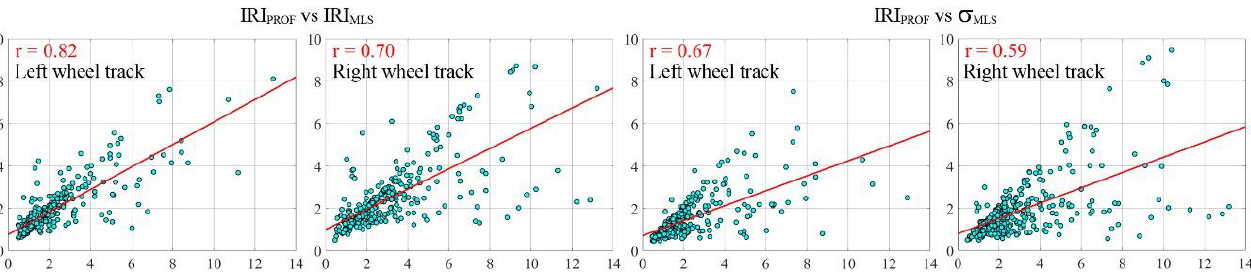
Figure 6. Diagrams of correlations.